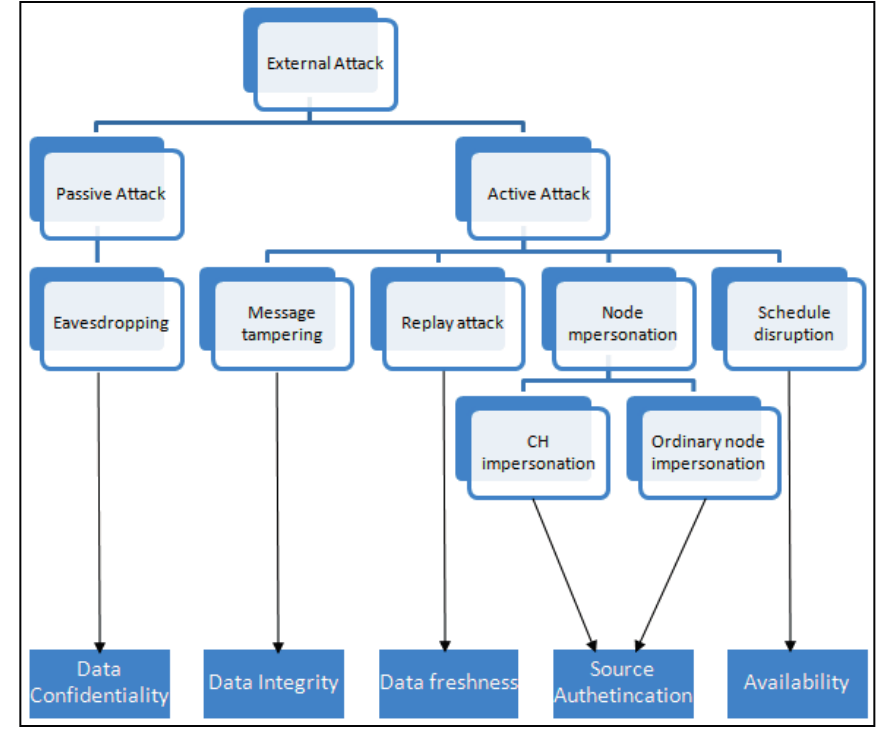
Figure 8. Relating each possible attack with the corresponding attacked security